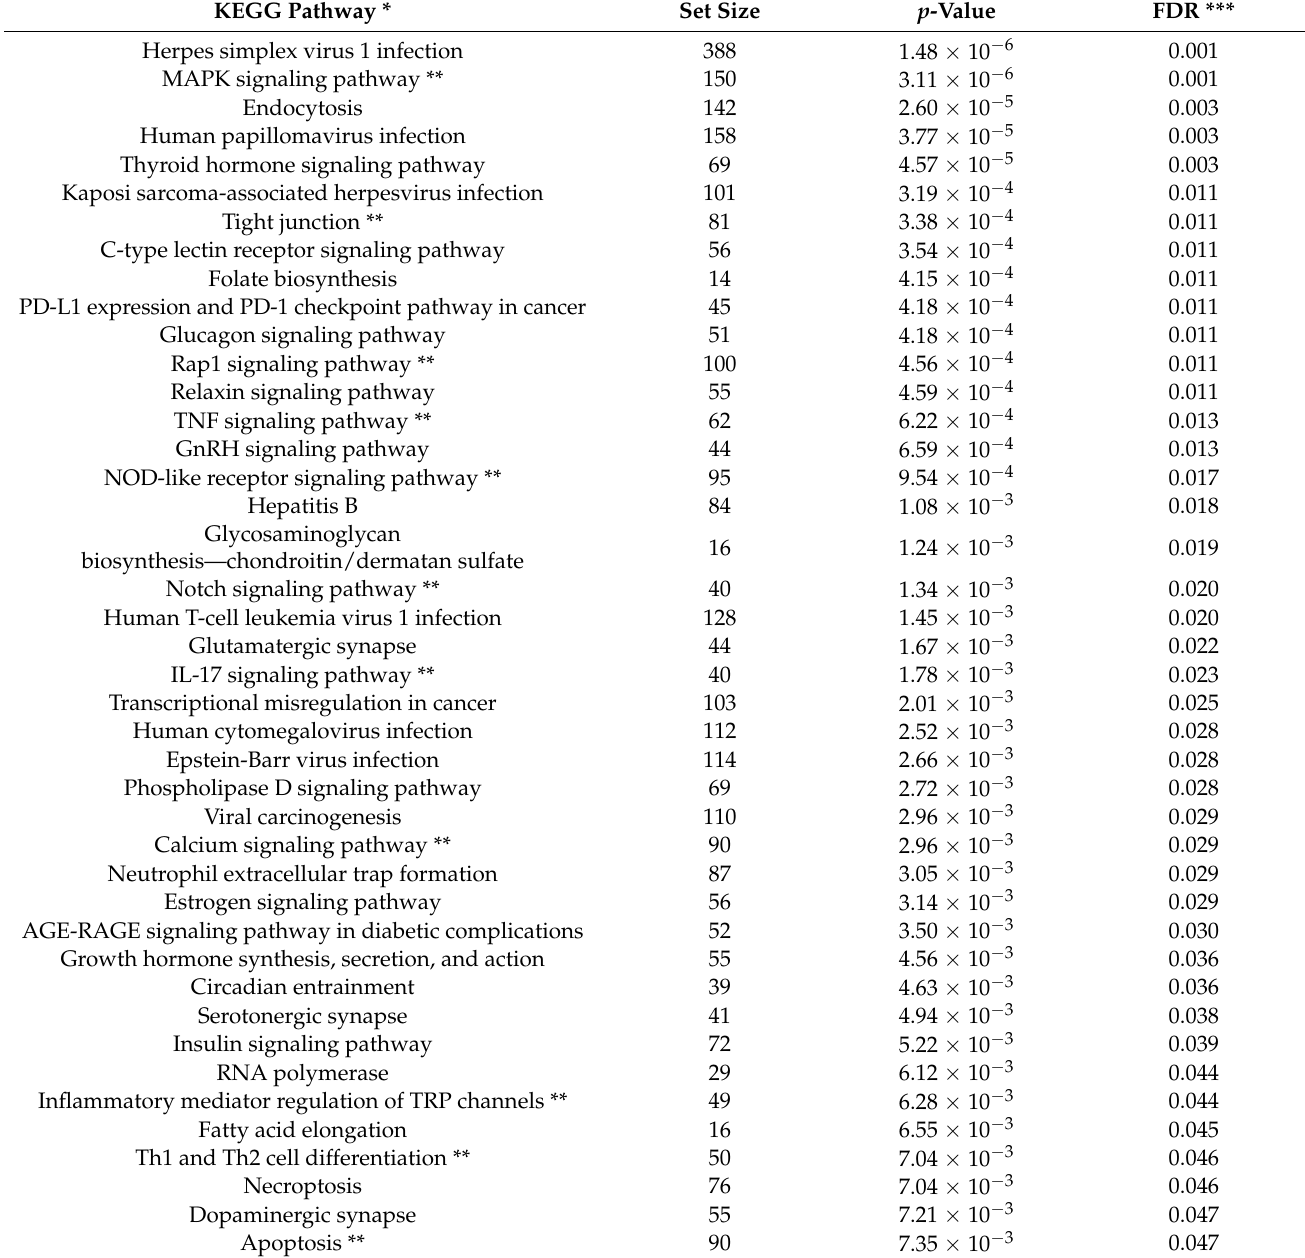
Table 4. Enriched biological pathways/processes involved in the CD4+ T cell activation by vaccine type (from interaction model 1: Day 28/Day 0 gene expression effect on immune outcome by vaccine